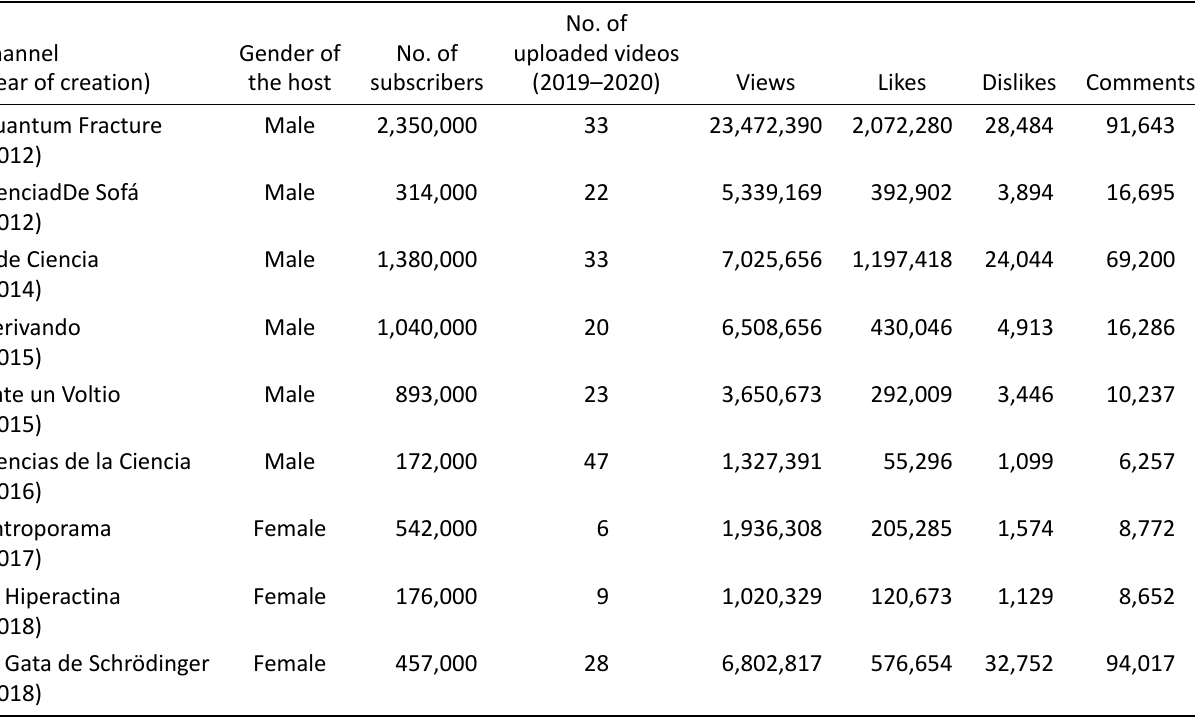
Table 1. Descriptive information on YouTubers/channels and science popularisation videos on YouTube with more than 100,000 subscribers in 2020.